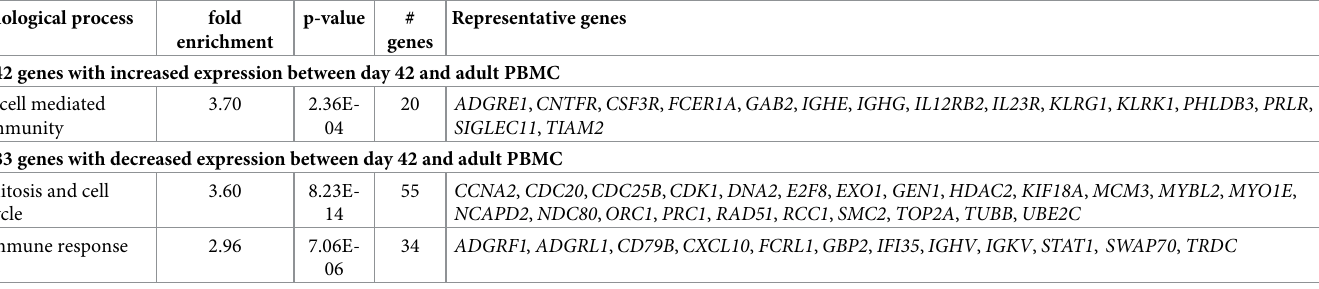
Table 4. Gene enrichment analysis of differentially-expressed genes between day 42 foal and adult horse samples. Biological process fold enrichment